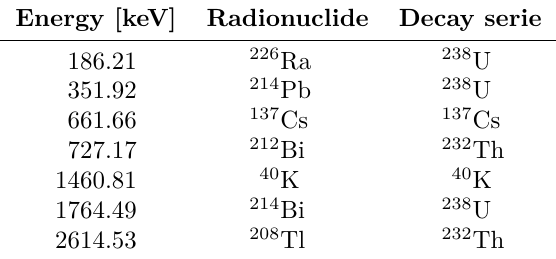
Table 1. The example photon energies simulated for the needs of this